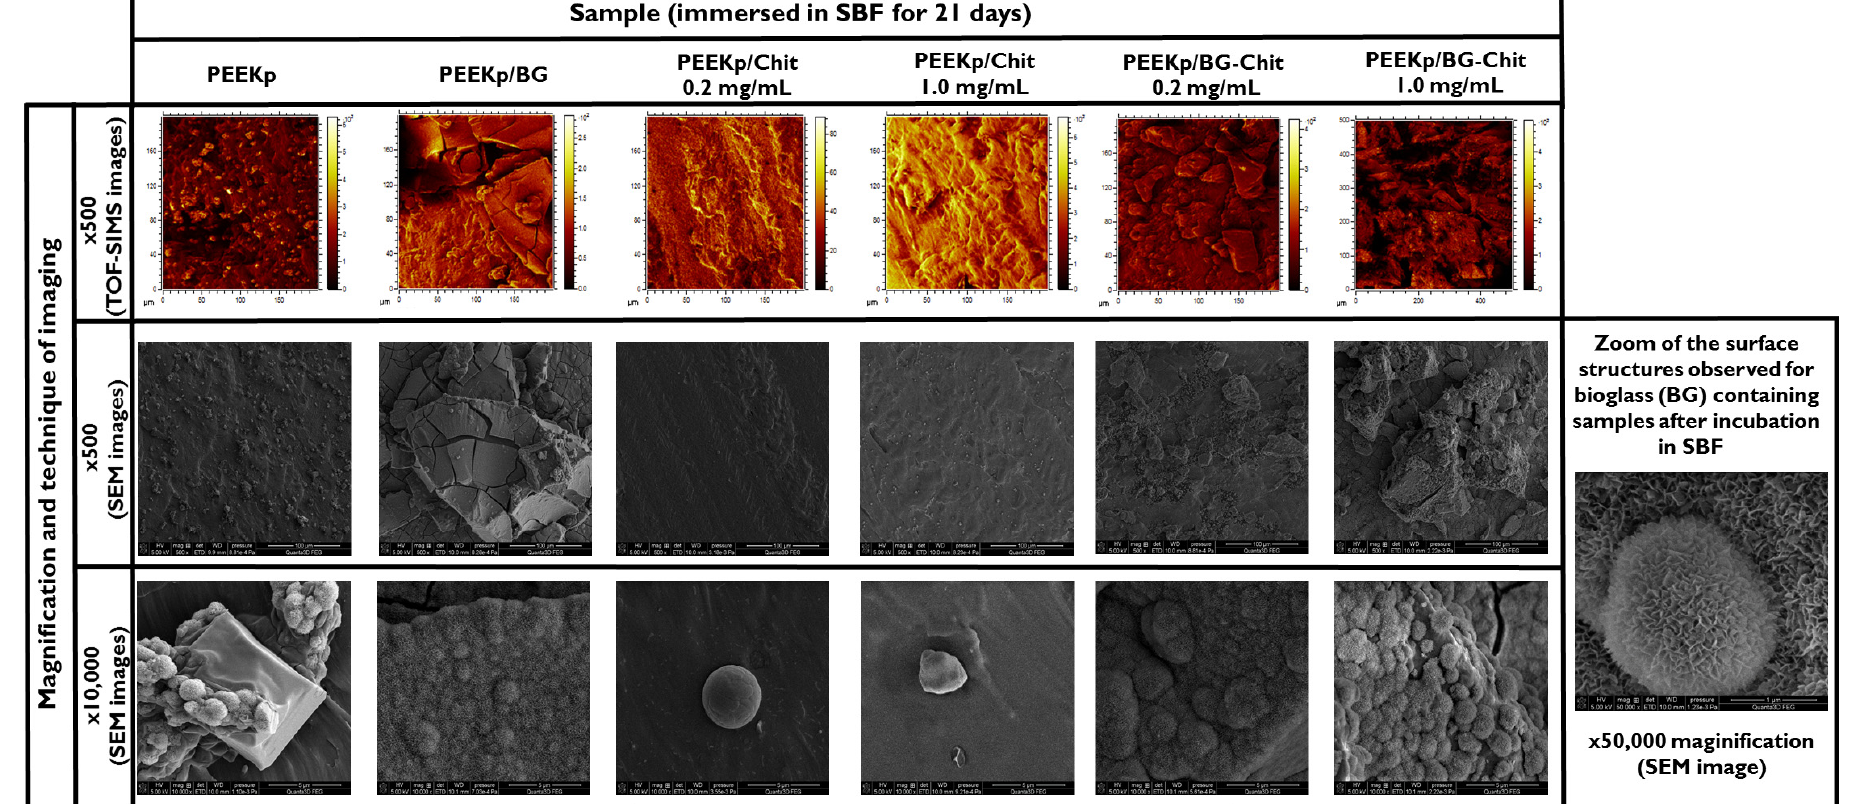
Figure 11. TOF-SIMS and SEM images of the modified PEEK surfaces after the immersion in SBF for 21 days.